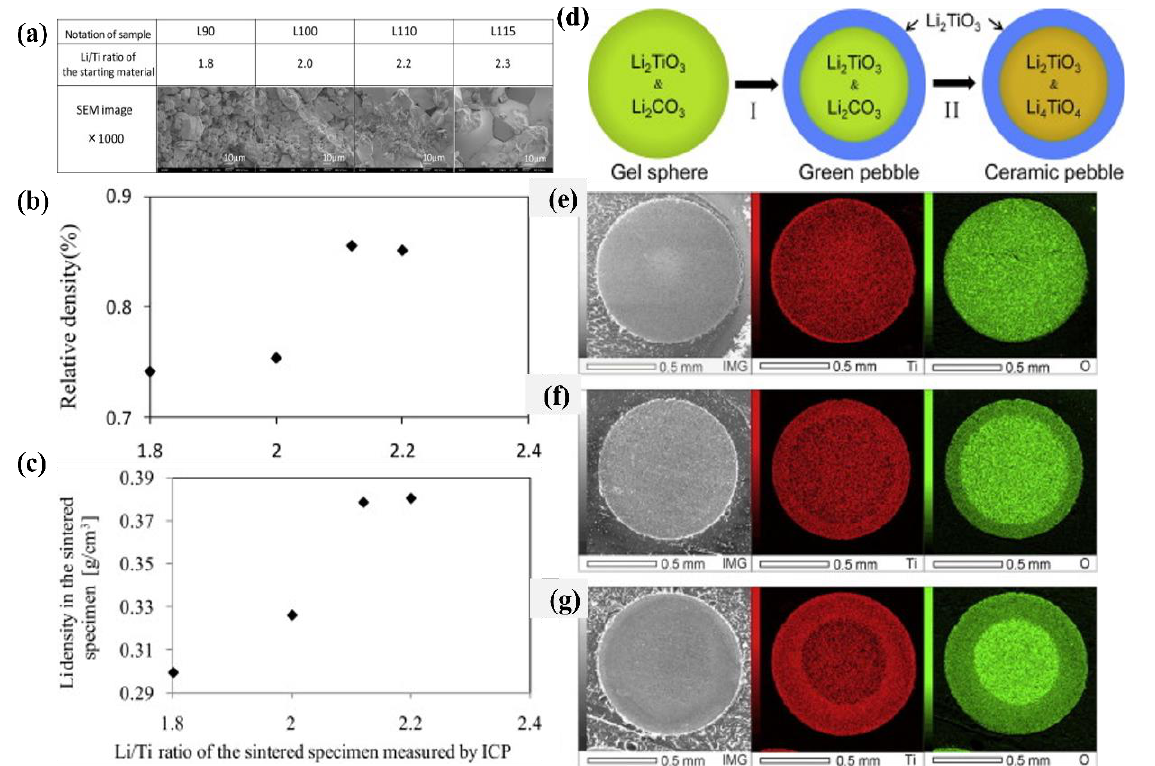
Figure 4. ( a ) SEM images of fracture cross-sections of sintered materials with different Li/Ti ratios. ( b ) Relative densities of the samples with different Li/Ti ratios. ( c ) Li density as a function of the Li/Ti ratio. Reprinted with permission from ref. [81]. ( d ) Schematic diagram of the formation of Li 2 TiO 3 pebble core – shell: (I) washing and drying; (II) calcining and sintering; cross-section of green pebbles with a Li/Ti molar ratio of 2.7, washing ( e ) 1 time, ( f ) 5 times, and ( g ) 10 times. Reprinted with permission from ref. [83].